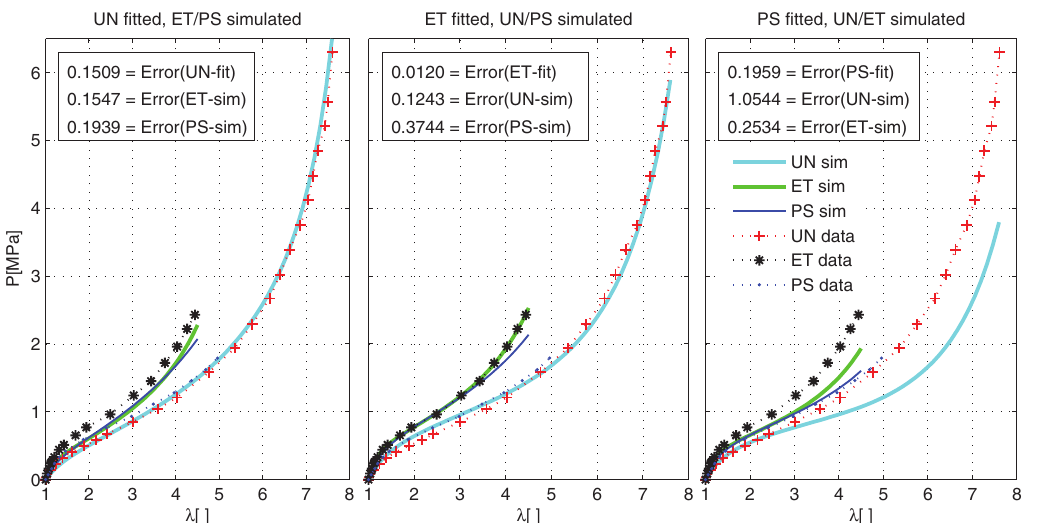
Figure 9: Performance of the Zuniga-Beatty version of the full-network model on the Treloar data. The fitting and simulations in all deforma- tion modes are excellent except an underestimation occurs in the case of UN data for the PS-fitted